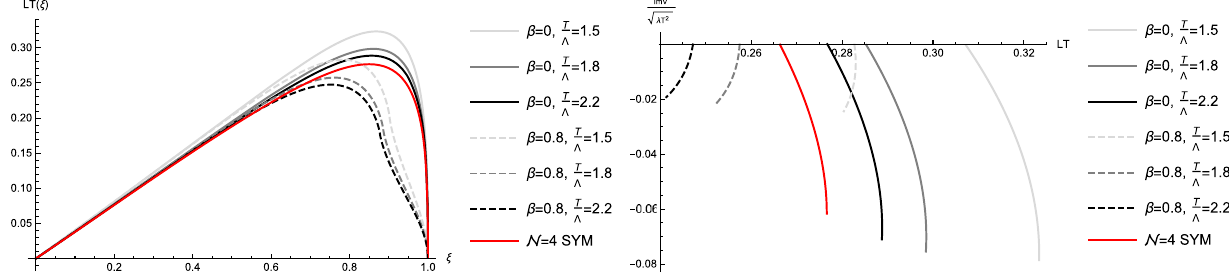
Fig. 3 The small black hole. Left: plot of LT versus ξ for different values of T /(cid:2) and β . Right: ImV T /(cid:2) and β